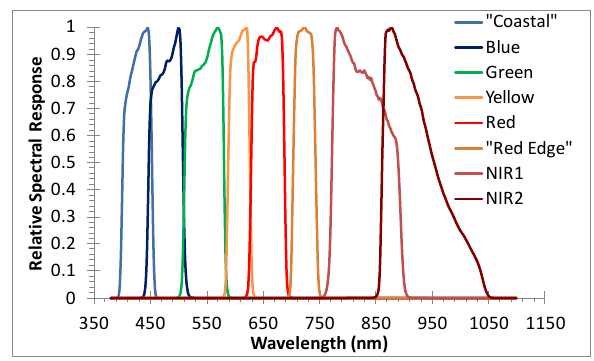
Figure 1. The relative spectral response curves of the 8 multispecral bands of the WorldView-2 satellite sensor.